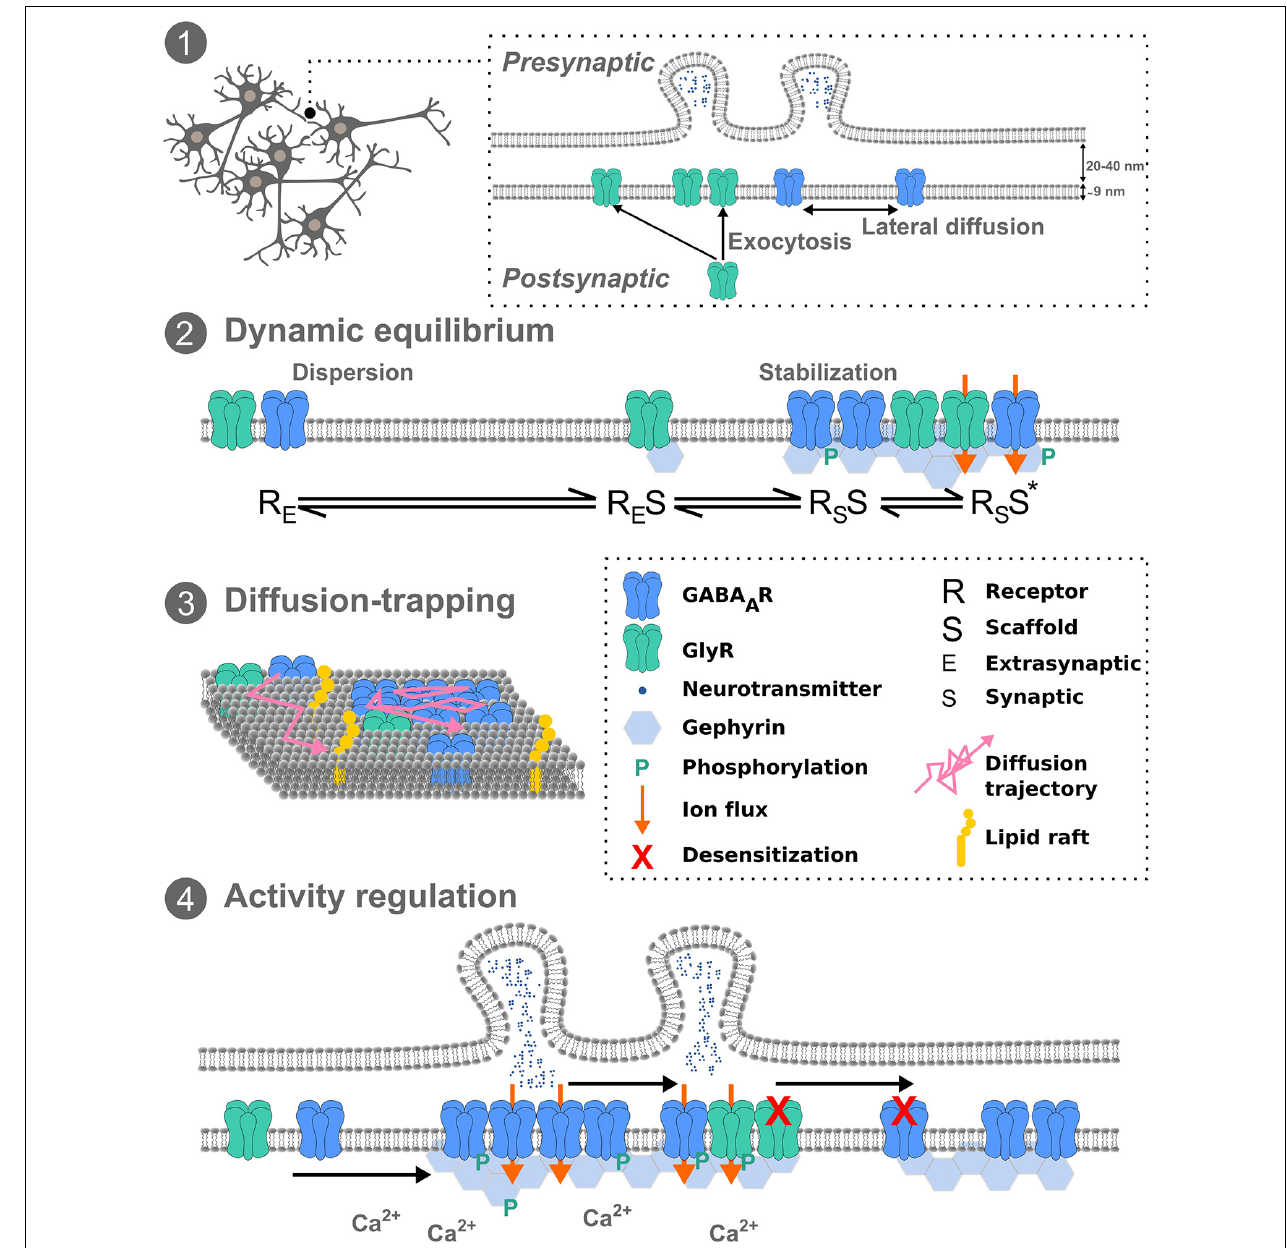
FIGURE 1 | Inhibitory receptor diffusion-trapping. (1) Overview schematic of pre- and postsynaptic inhibitory neuronal membranes, exocytosis, and lateral diffusion. (2) The dynamic equilibrium between stabilized and freely mobile receptors, at the synapse and extrasynaptically, respectively. (3) Receptor diffusion-trapping depends not only on chemical interactions with synaptic components but also on non-specific obstacles, such as lipid rafts, leading to molecular crowding. (4) Activity regulation of receptor mobility can affect post-translational modifications of receptors and scaffold proteins and subsequently their immobilization at synapses. Exchange of receptors between synapses can fine-tune network